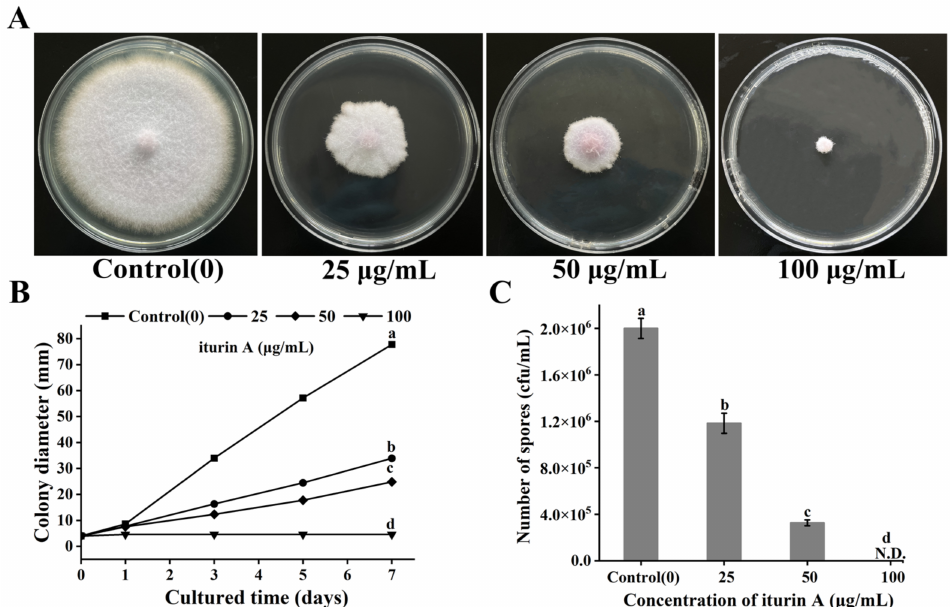
Figure 1. ( A ) Colony morphology of F. oxysporum in PDA medium cultured with iturin A for 7 days; ( B ) effects of iturin A on colony diameter of F. oxysporum ; ( C ) effects of iturin A on F. oxysporum spore production (different letters represent significant differences between treatments, p < 0.001; N.D.: Not Detection).